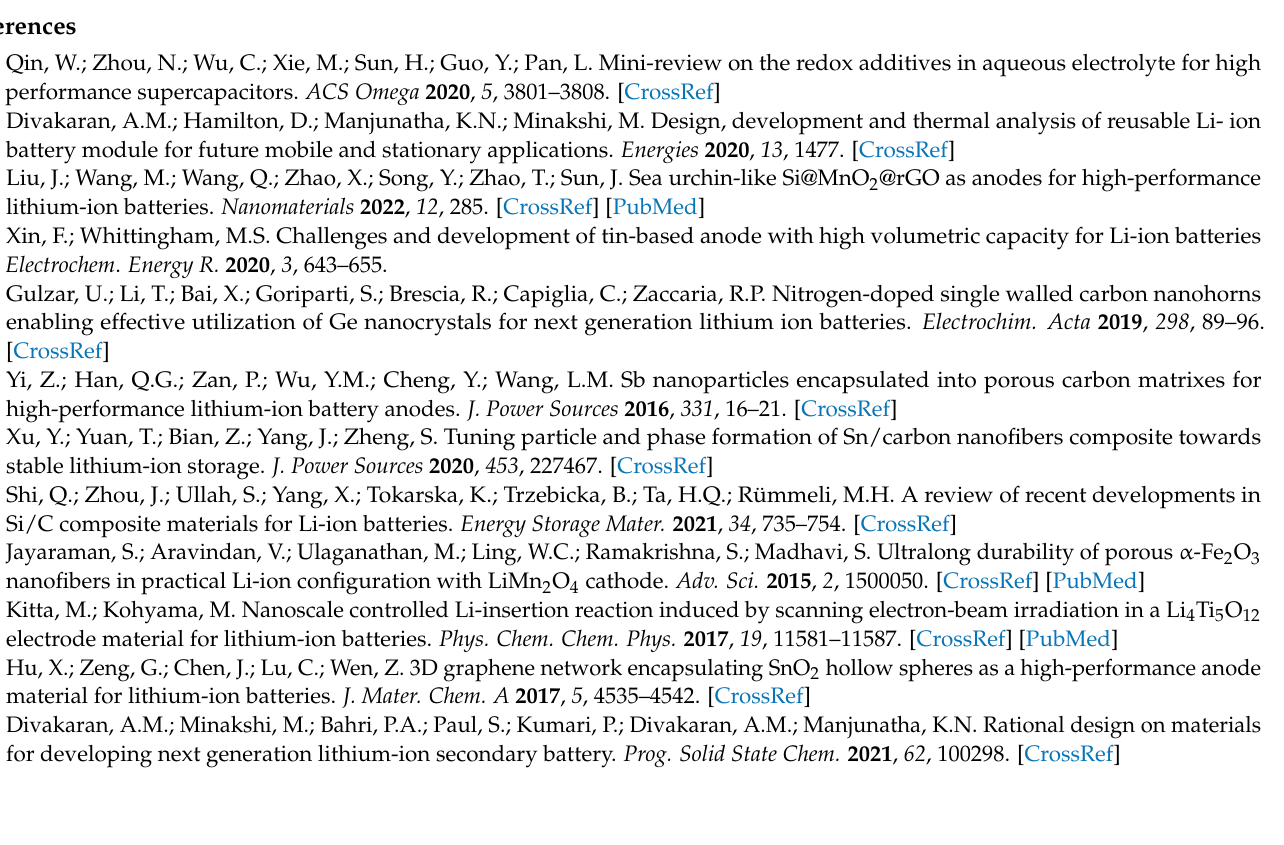
Figure S2. (a) N2 adsorption-desorption isotherms and their as-calculated structural parameters